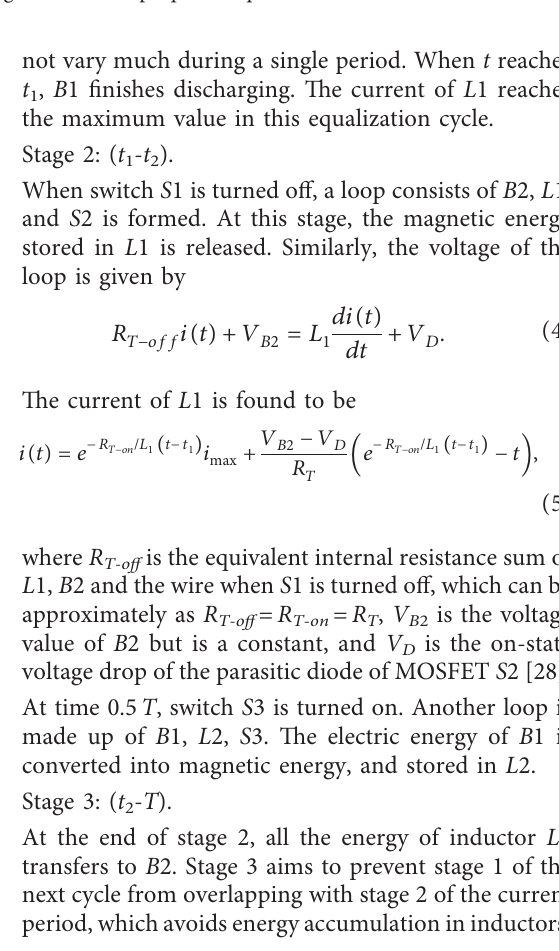
Figure 4: (a) The equalization circuit topology; (b) the enlargement of the proposed equalization unit EU 1-1.